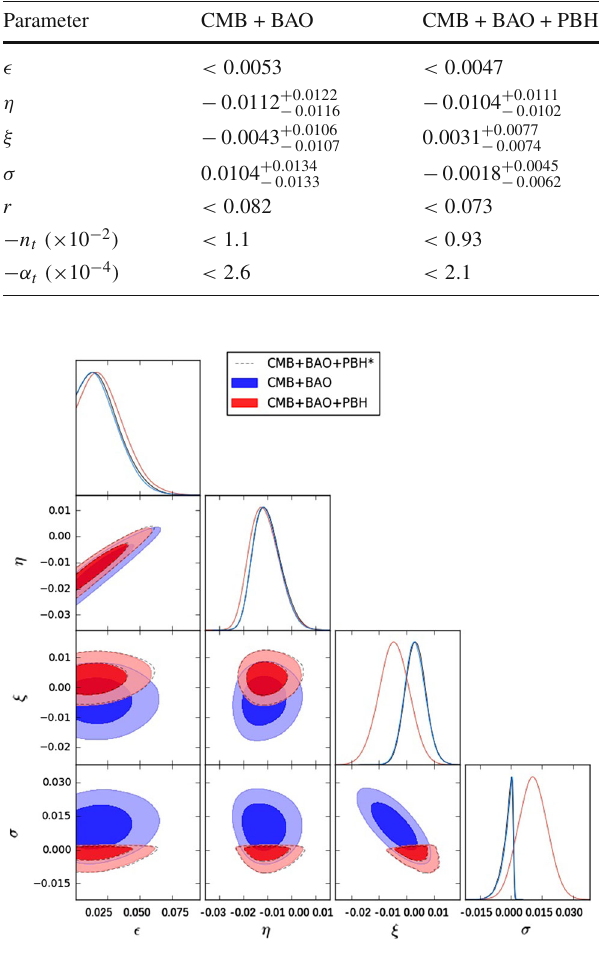
Fig. 2 The contour plots and the likelihood distributions for the slow-roll parameters (cid:12) , η , ξ and σ at the 68% and 95% CL from CMB + BAO + PBH*, CMB + BAO and CMB + BAO + PBH, respec- tively